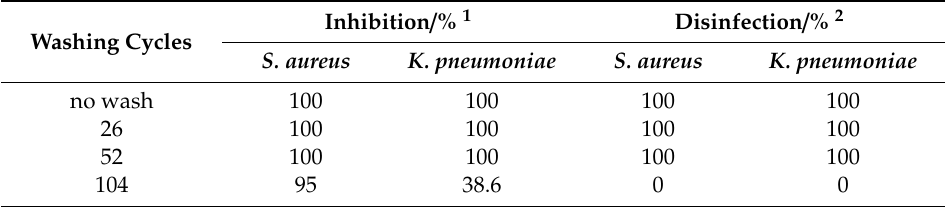
Table 4. Antibacterial properties of treated samples washed by di ff erent cycles.